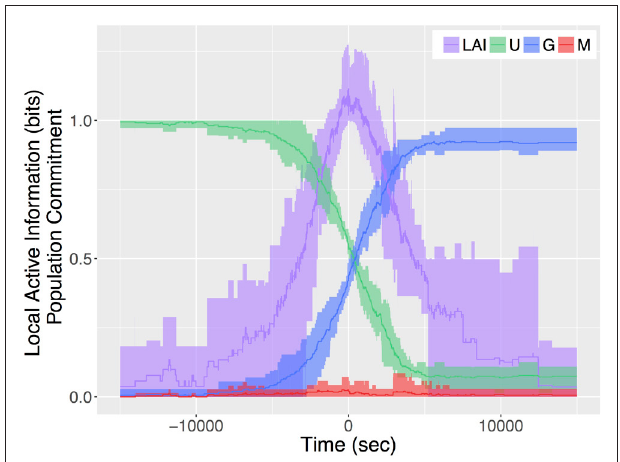
fIguRe 2 | Distribution of local active information and colony-level commitment state for a live colony of 78 T. rugatulus ants computed over 5 colony emigrations. Lines represent mean values of local active information ( lAI ), and proportions of ants in the colony that are uncommitted ( u ), committed to the good site ( g ) and committed to the mediocre site ( m ). Shaded areas correspond to minimum and maximum values of the same